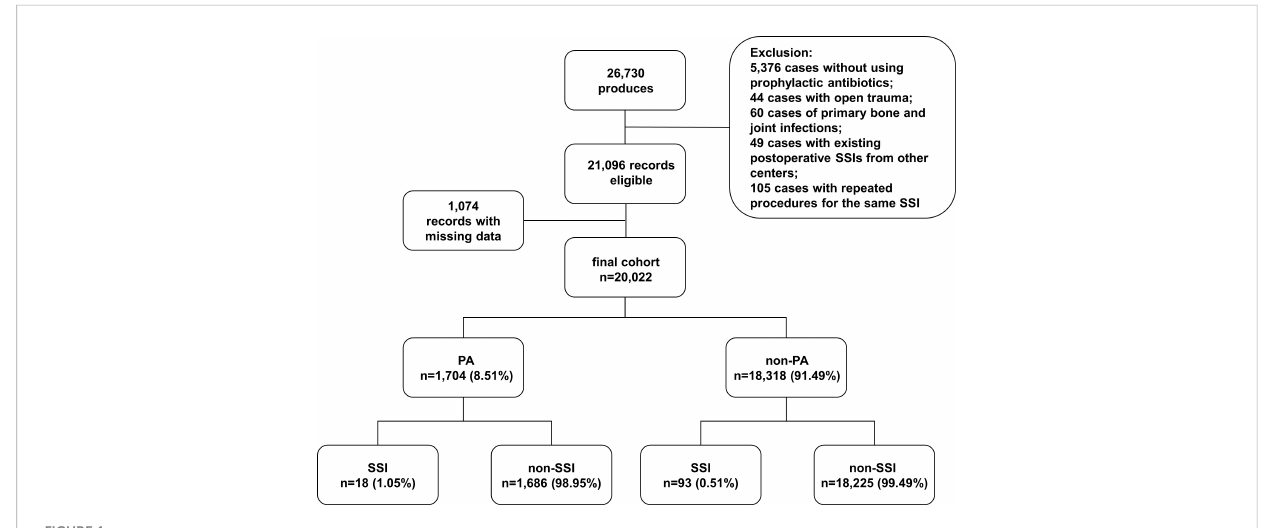
FIGURE 1 Flow diagram shows the study